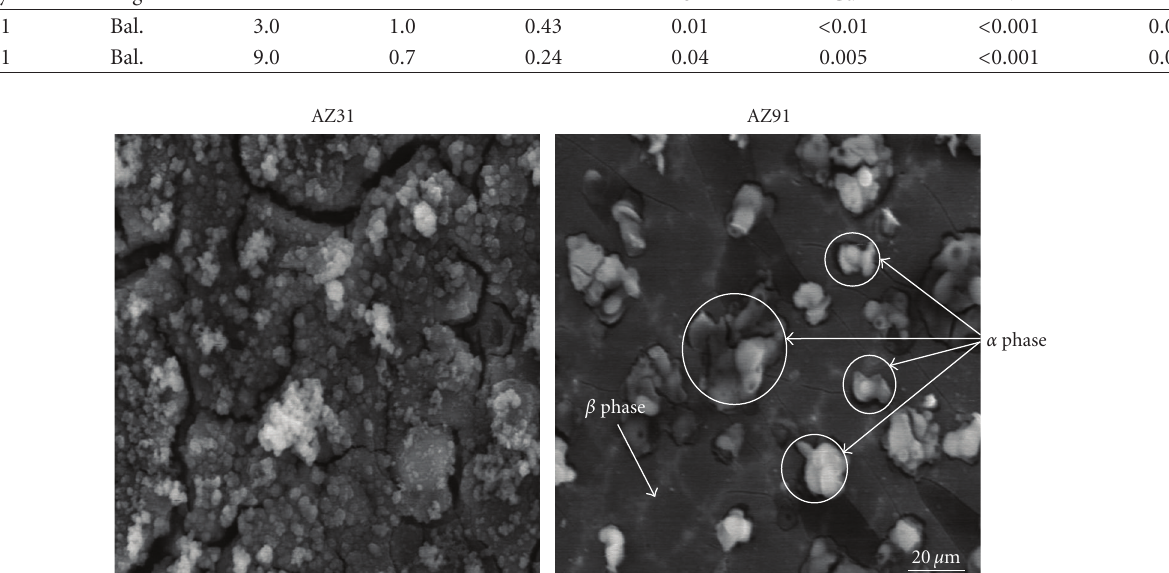
Figure 4: Surface morphologies of AZ31 and AZ91 magnesium alloys after 5 h OCP in 3.5 mass % NaCl solution.